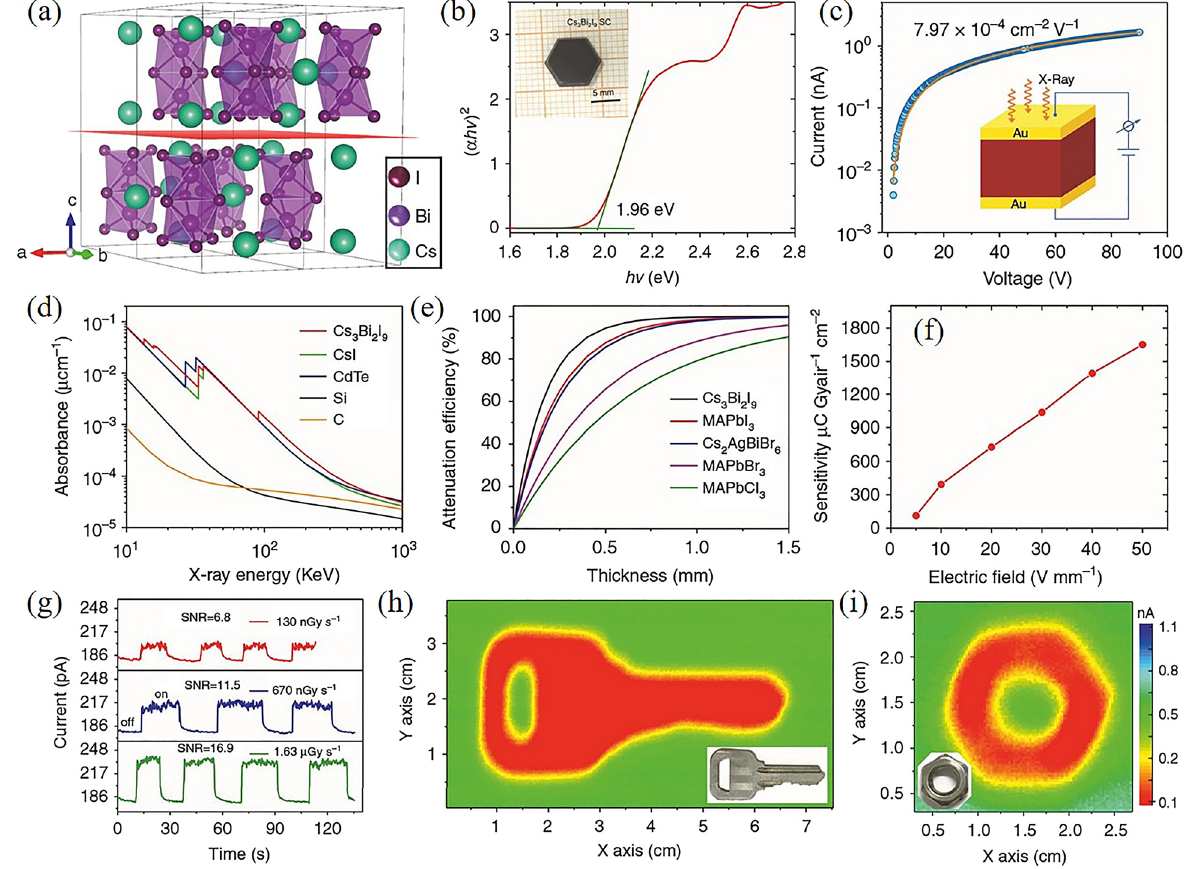
Figure 13: 0D Bi-based perovskite variants (Cs 3 Bi 2 I 9 ) for X-ray detection. (a) Schematic view of the 0D Bi-based perovskite variant. Cs 3 Bi 2 I 9 and MA 3 Bi 2 I 9 respect the same crystal structure. (b) Estimation of the bandgap of Cs 3 Bi 2 I 9 with Tauc plot from the absorption spectrum. Inset: Photograph of a representative Cs 3 Bi 2 I 9 single crystal. (c) Estimation of the μτ product of the Cs 3 Bi 2 I 9 single crystal by photoconductivity measurement. Inset: Schematic view of the device structure. (d) Photon energy-dependentX-rayabsorptioncoef fi cientsofCs 3 Bi 2 I 9 ,CsI,CdTe,Si,andcarbon.(e)Comparisonofthethickness-dependentattenuation ef fi ciency of Cs 3 Bi 2 I 9 , MAPbI 3 , Cs 2 AgBiBr 6 , MAPbBr 3 , MAPbCl 3 , Si, and carbon towards X-ray photons of 40 keV energy. (f) Sensitivity of the Cs 3 Bi 2 I 9 singlecrystaldetectorundervariouselectric fi elds.(g)PhotocurrentresponseoftheCs 3 Bi 2 I 9 singlecrystaldeviceupondifferentX-ray dose rates(40kV photon energy, @50 V mm − 1 electric fi eld).(h) – (i)X-rayimagingof a keyand a nutwith the Cs 3 Bi 2 I 9 single crystaldetectorof 1 × 1 mm 2 (50 V mm − 1 electric fi eld, 36.2 µGy air s − 1 X-ray dose rate). Adapted with permission. Copyright 2020, Springer Nature